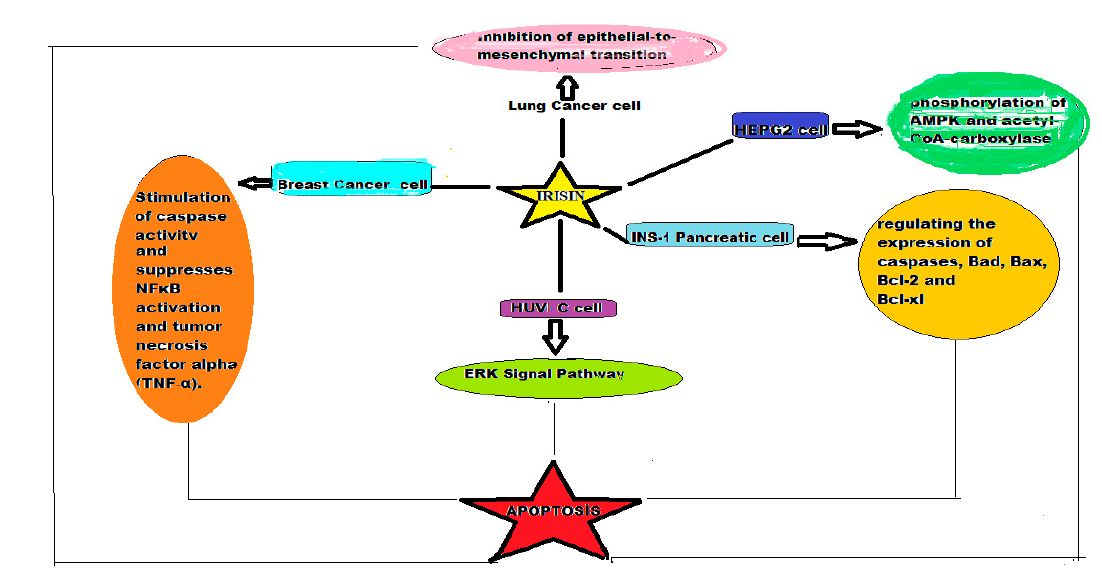
Figure 2. Apoptosis mechanisms of Irisin on different cancer